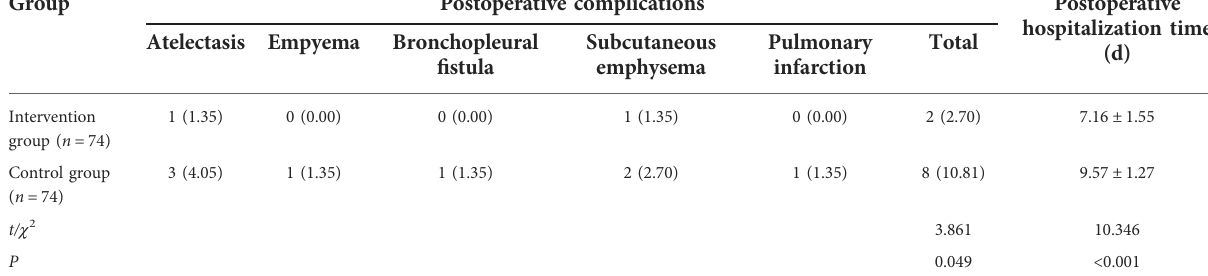
TABLE 2 Comparison of postoperative complications and hospitalization duration between the two groups before and after intervention. Group